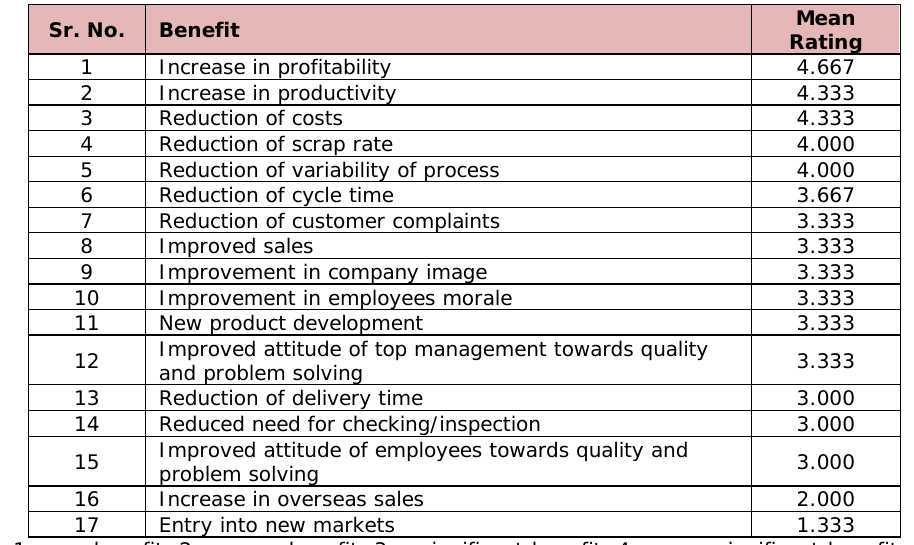
Table 2. “Benefits gained due to Six Sigma implementation by large scale industries (Mean ratings arranged in descending order of benefit)”.